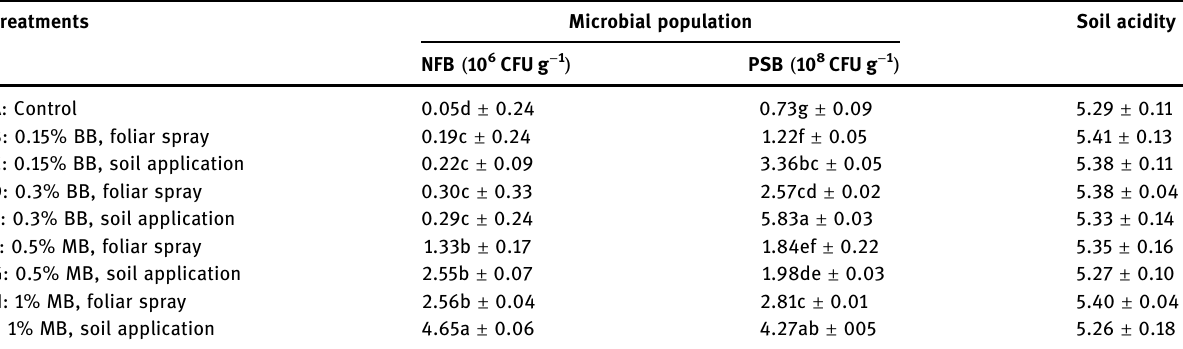
Table 4: E ff ect of biofertilizer treatments on nitrogen - fi xing bacteria, phosphate - solubilizing bacteria, and pH in soil at 24 weeks after transplanting in the greenhouse